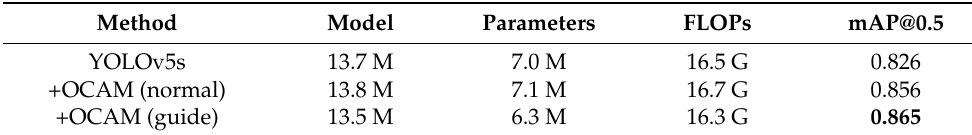
Table 3. Comparison of attention layer design